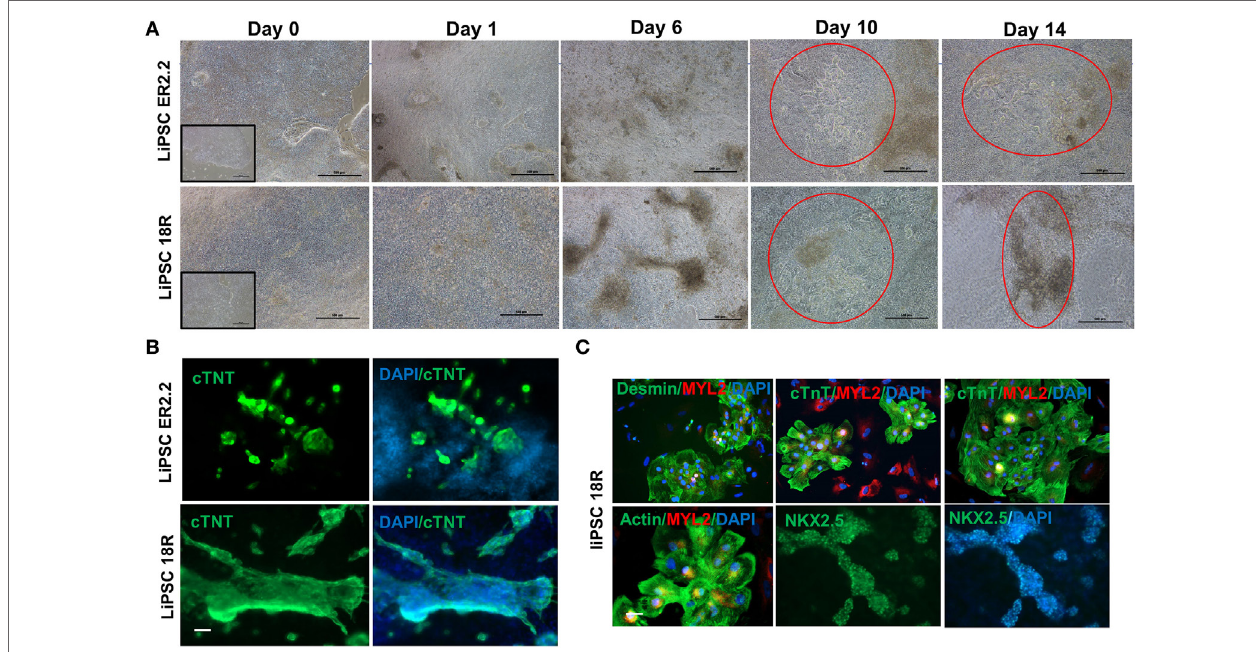
FigUre 2 | Both current good manufacturing practice-compliant LiPSCs lines (18R and ER2.2) differentiated into beating cardiomyocytes in two-dimensional (2D) culture system. (a) starting with good quality cells (around 100% confluency with very low differentiated areas), both hiPSC lines started morphological changes from day 1 onward until day 14. The first beating observed for both lines around days 6–7 within several patches. A large beating area has been shown for each line on days 10 and 14 (red circles). (B) All of the beating areas on day 14 of differentiation were positively stained for cardiac-specific troponin (cTnT) marker for both hiPSC lines. A representative large cardiac patch (a few millimeter size) has been shown here for each line. (c) LiPSC 18R was characterized for more cardiomyocyte markers (Desmin, myosin light chain 2, and Actin) and stained positive for cardiac progenitor marker (NKX2.5). Scale bar: 100 µm.